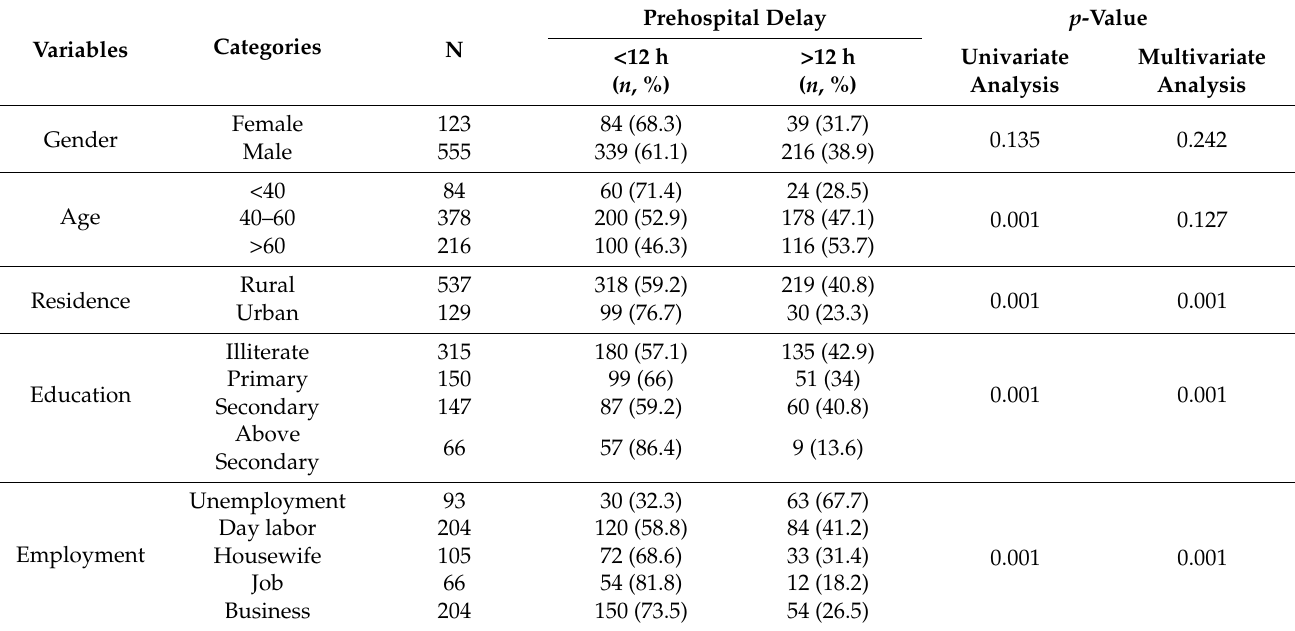
Table 2. Association between sociodemographic characteristics and prehospital delay.